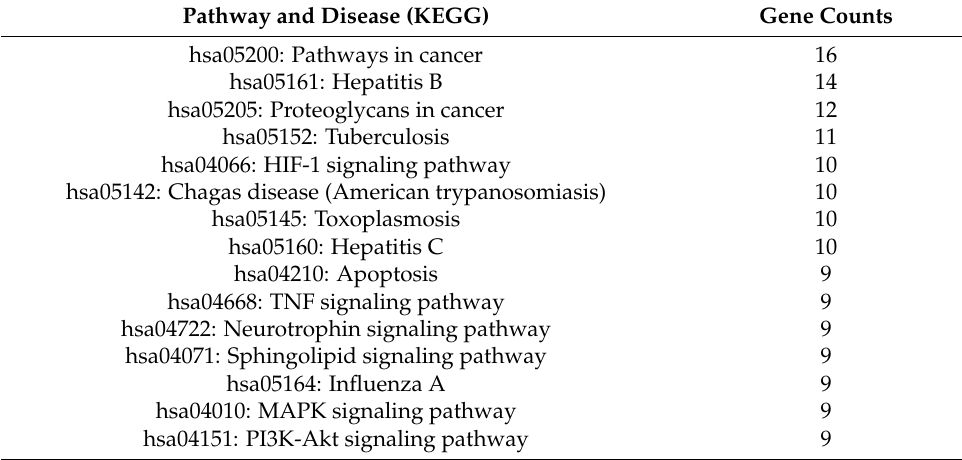
Figure 1. ( A ) Biological targets of quercetin and influenza infection. Thirty overlapping targets were identified. ( B ) Quercetin (compound)–Influenza infection (disease) target network (C-D network). Table 1. Pathway and Disease KEGG